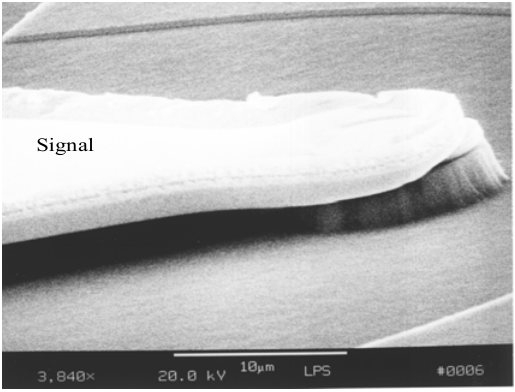
Figure 9. 10-µm diameter photodetector with coplanar metal waveguide.